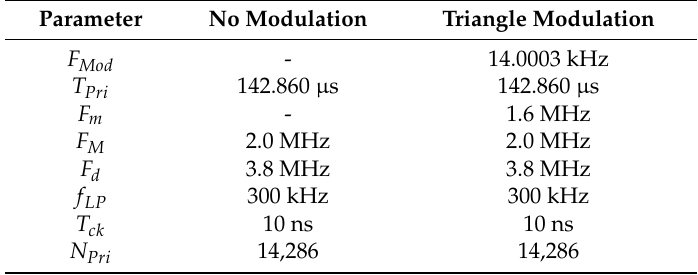
Table 2. Parameters used in simulations when conditions for noise suppression were not